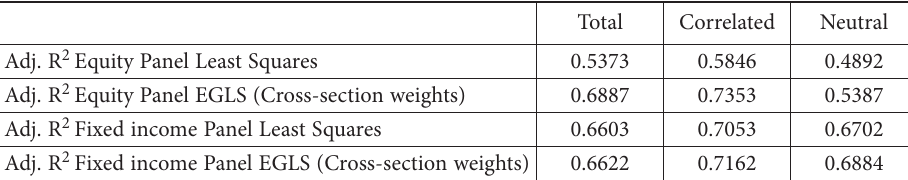
Table 12. Nordic panel data models with applied cross-sectional Fixed Effect